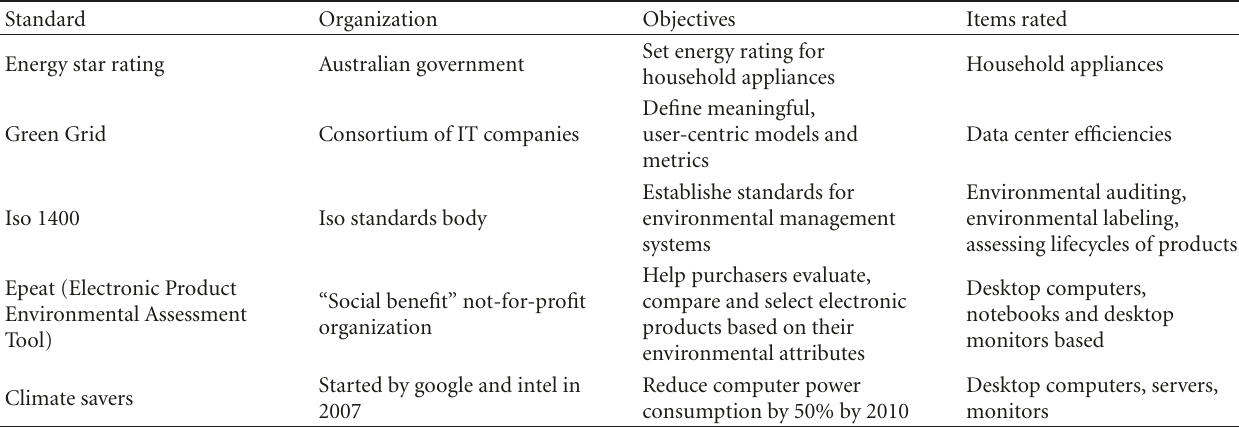
Table 1: Green Network